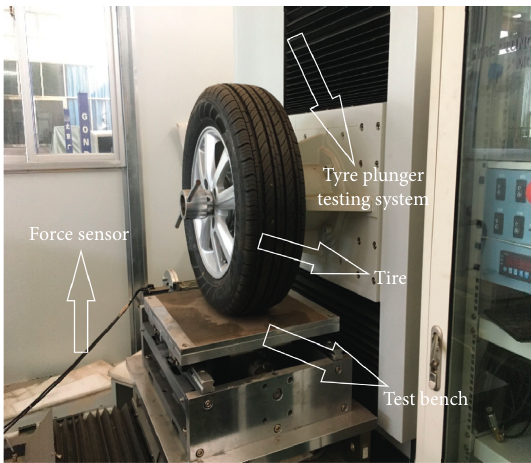
Figure 6: Bench test for mechanical properties of the tire.